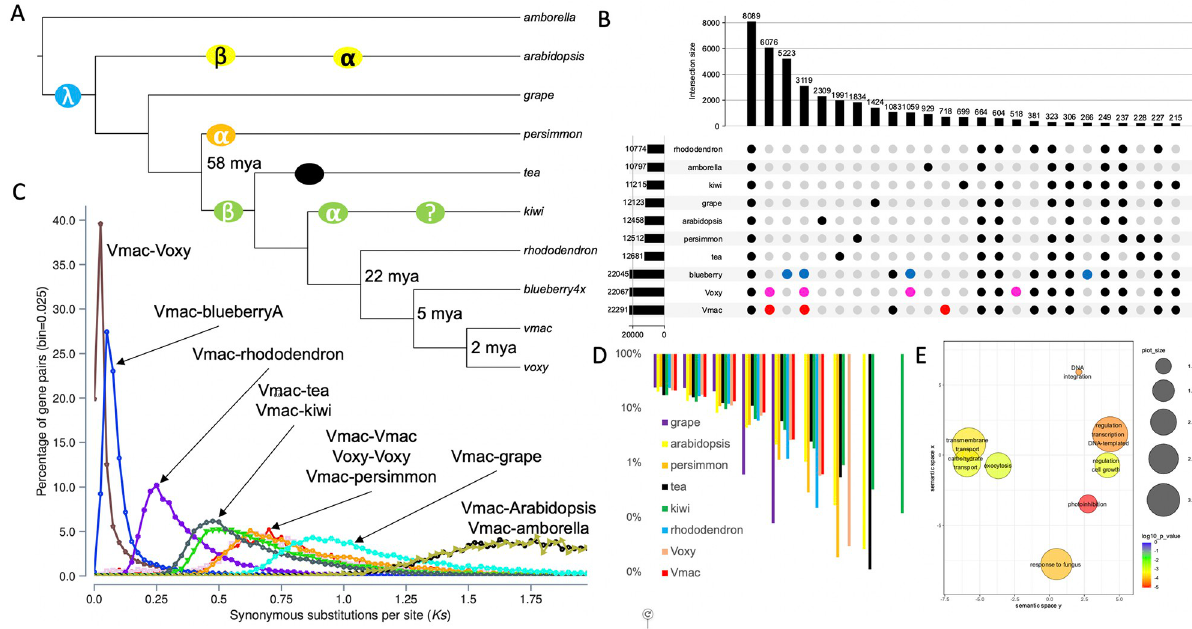
Fig 4. Whole genome duplication evolution of cranberry. A) Phylogenetic tree built with single copy proteins across amborella ( Amborella trichopoda ), arabidopsis ( Arabidopsis thaliana ), grape ( Vitis vinifera ), persimmon ( Diospyros lotus ), tea ( Camellia sinensis ), kiwi ( Actinidia chinensis ), rhododendron (Rhododendron williamsianum ), blueberry 4x (tetraploid Vaccinium corymbosum ), Vmac, and Voxy. Circles symbolize whole genome duplications (WGD) events. B) Upset plot of the overlap between gene families. Red, pink and blue dots emphasize some of the similarities and differences among the Vaccinium spp. C) Synonymous substitution (Ks) distribution plot across species. D) Shared syntenic blocks compared to amborella across species. E) Significant gene ontology (GO) terms for cranberry (Vmac and Voxy) specific orthogroups (OGs) plotted in semantic space.